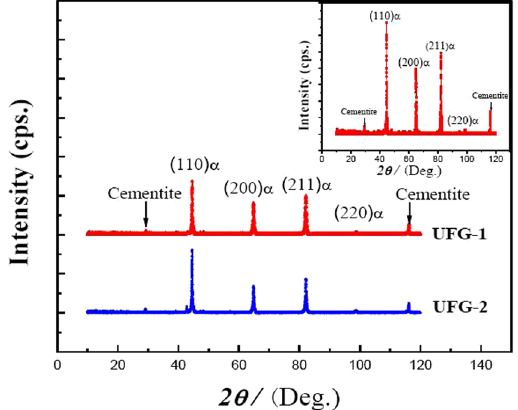
Figure 1. XRD patterns of experimental steels with chemical composition of 1.05Cr-1.01Mo-0.73Mn-0.61Ni- 0.17Si-0.09V-0.43 C, in wt.%. The upper right inset shows the magnified pattern of UFG-2 steel.